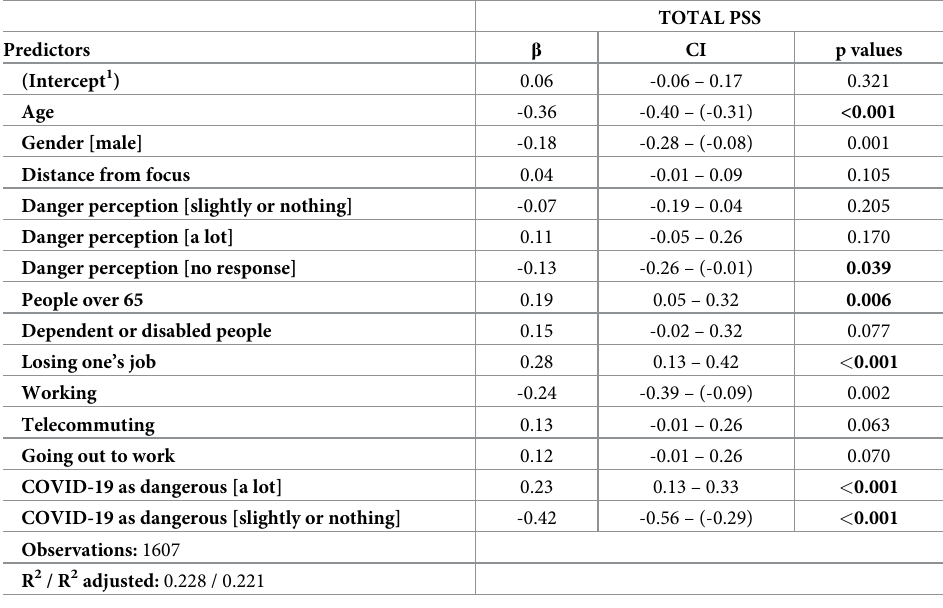
establishing routines ( β = 0.32, p < 0.001) and perceiving the COVID-19 situation as not or slightly dangerous ( β = -0.16, p = 0.046). These variables (significant and non-significant) explain only around 5% of the non-planning score variance ( r 2 adjusted = 0.049) (see Table 8). The BIS motor score is influenced by living with children ( β = -0.14, p = 0.011), working during lockdown ( β = -0.29, p < 0.001), working in the health sector ( β = -0.39, p = 0.019) and establishing routines during lockdown ( β = -0.36, p < 0.001). All these variables (significant and non-significant) explain 7% of the motor score variance of the BIS ( r 2 adjusted = 0.07) (see Table 9). The cognitive score is influenced by age ( β = -0.24, p < 0.001), gender (being male) ( β = -0.19, p = 0.001), living with children ( β = -0.24, < 0.001), working ( β = -0.27, p < 0.001), tele- commuting ( β = 0.13, p = 0.047) and establishing routines during lockdown ( β = -0.23, p < 0.001). These variables (significant and non-significant) explain 14% of the cognitive score variance ( r 2 adjusted = 0.14) (see Table 10). Table 7. Regression analysis relating to perceived